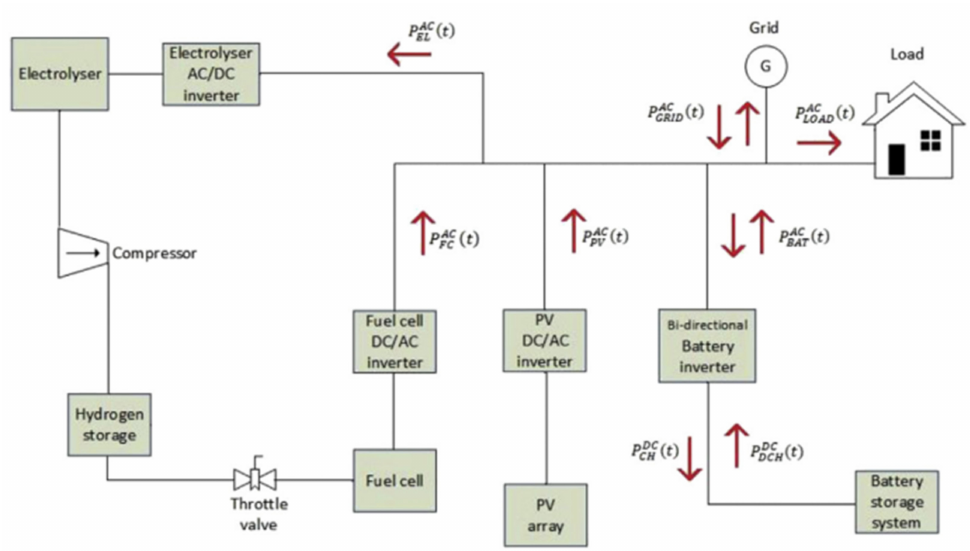
Figure 6. Scheme of the system configuration, fuel cells, and battery storage system used on [21]. No changes were made to the original